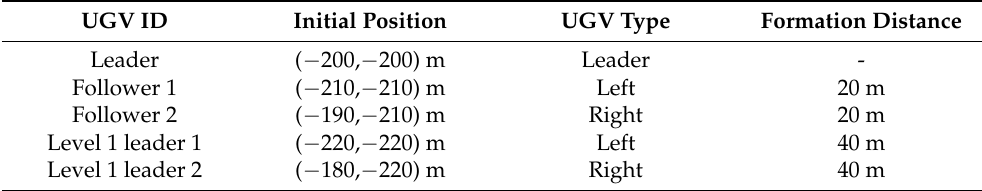
Table 4. List of Parameters Used in the Testing of a Double-layer Triangle